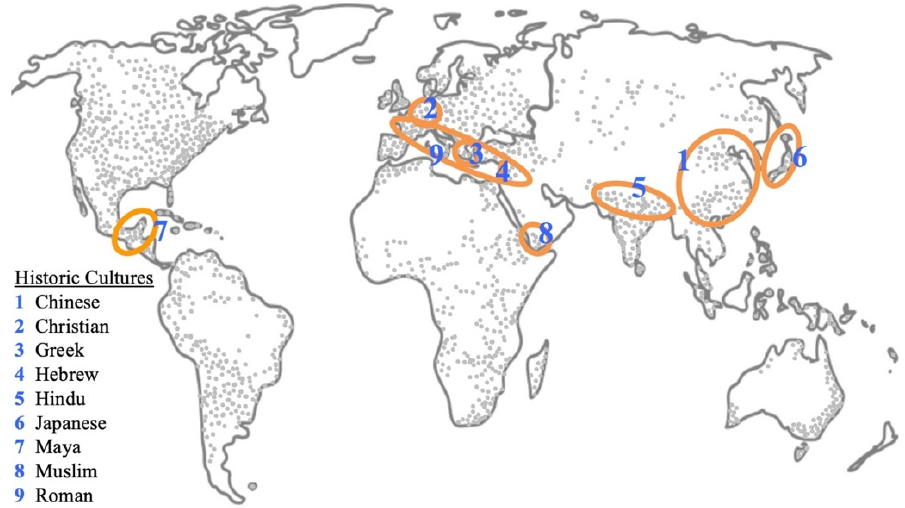
Figure 2. Map of the historic cultures investigated by us with ethnobotanical reference to duck- weeds. The background map shows the multitude of locations of duckweed accessions [1], the great majority of which were collected in modern times. The circled areas show the locations of the classic cultures described here. While Theophrastus geographically pinpointed reference to duckweed to a local site in Greece [10], Dioscorides’ descriptions were presented in the wider context of his travels in the Roman Empire [11]. The references to duckweed in Chinese culture are for the Later Han [12] and Ming [13] dynasties and in the Hindu religious texts to the Himalayan cedar forests [14]. The other areas encircled encompass the general regions or countries where the cultural references occurred.